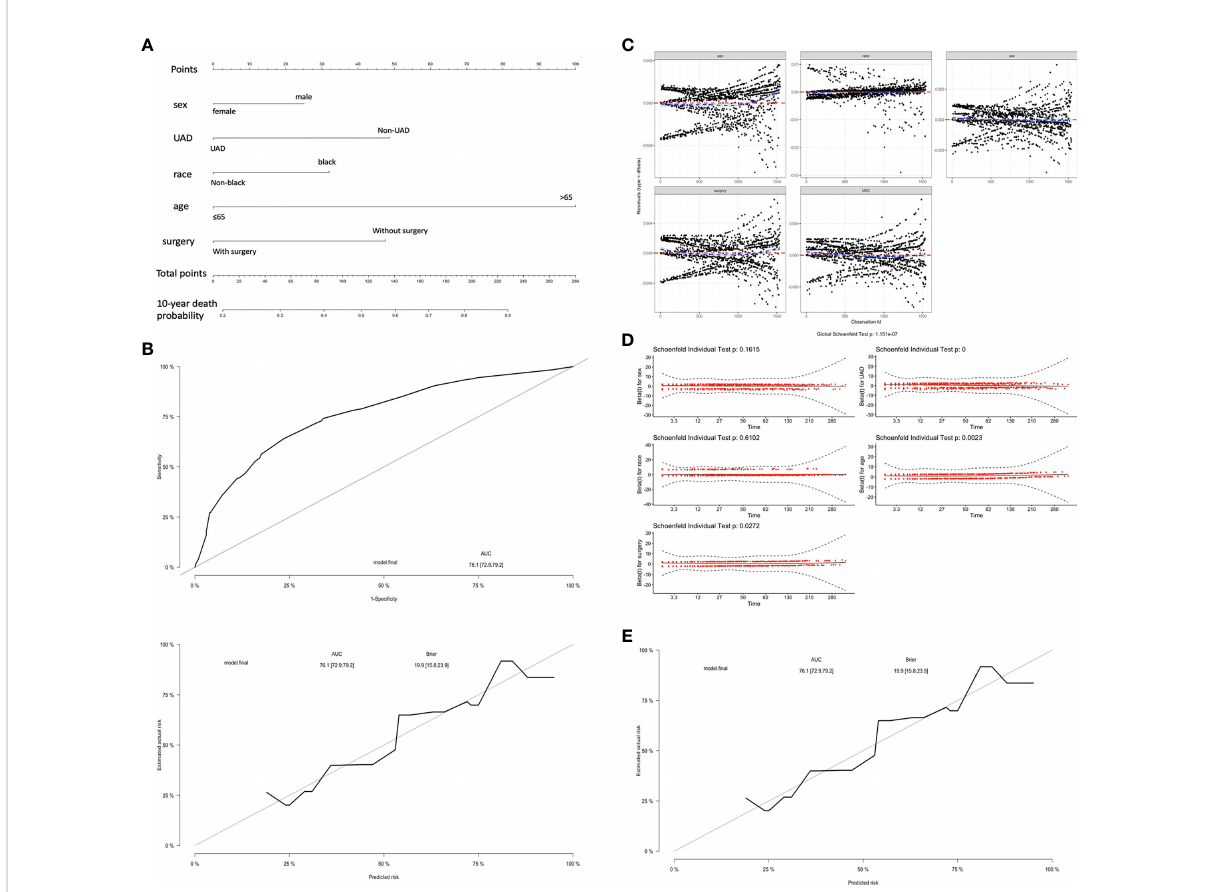
FIGURE 5 A nomogram model for 10-year death probility of patients with EMP (A) . The ROC plot predicted 10-year death probility for the AUC was 0.761 (95% CI 0.729 – 0.792) and the Brier score obtained from the model was 0.199 (95% CI 0.158 – 0.239) (B) . Outlier detection was designed by deviation residual test (C, D) .The value of AUC and the Brier score in the internal validation (E)